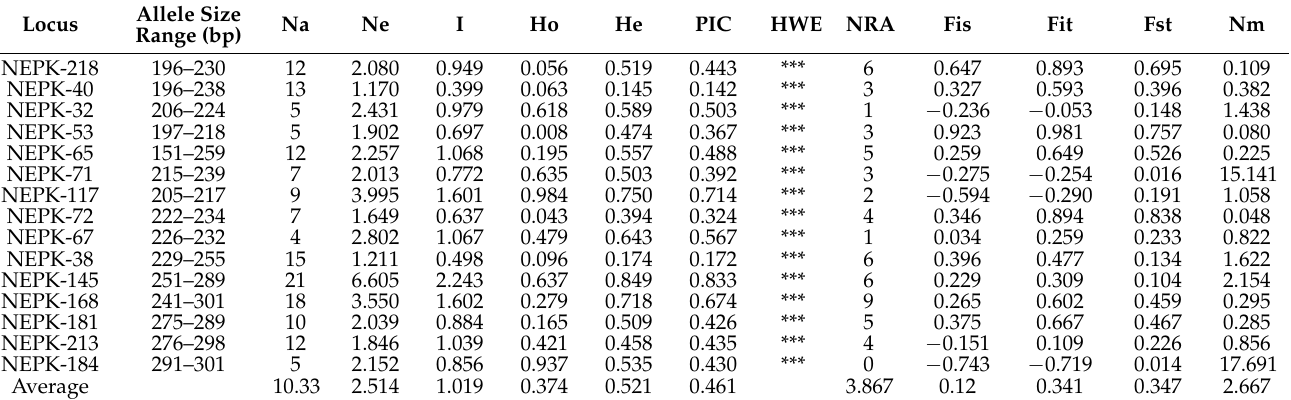
Table 1. Characteristics of the 15 polymorphic EST-SSR markers used in this study. Allele Size Locus Range